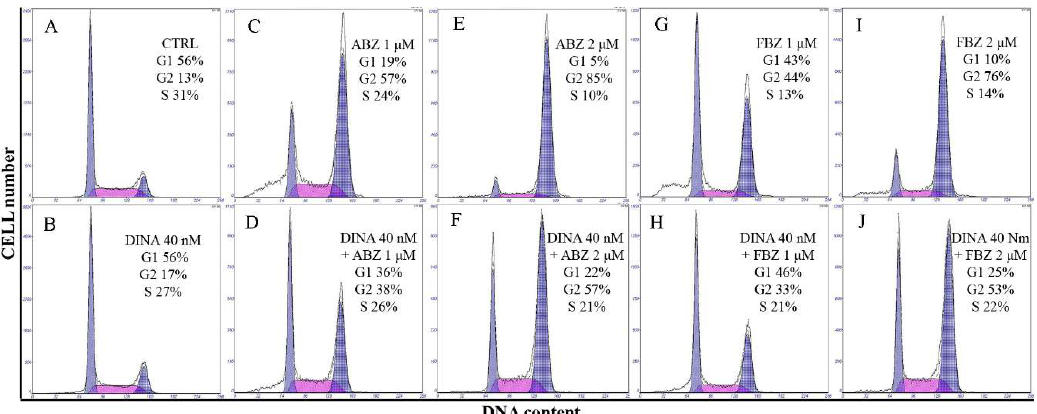
Figure 5 . ABZ and FBZ arrest cell cycle at G2/M phase. Flow cytometry analysis of PI-stained cells. ( A ) Control, DMSO treated cells. ( B ) Cells treated with DINA. ( C, E, G, I ) ABZ and FBZ (1 and 2 μM) and their combinations with DINA (40 nM, D, F, H, J ) significantly increased the proportion of A375 cells in G2/M phase. DINA alone had no significant effect on the cell cycle distribution.